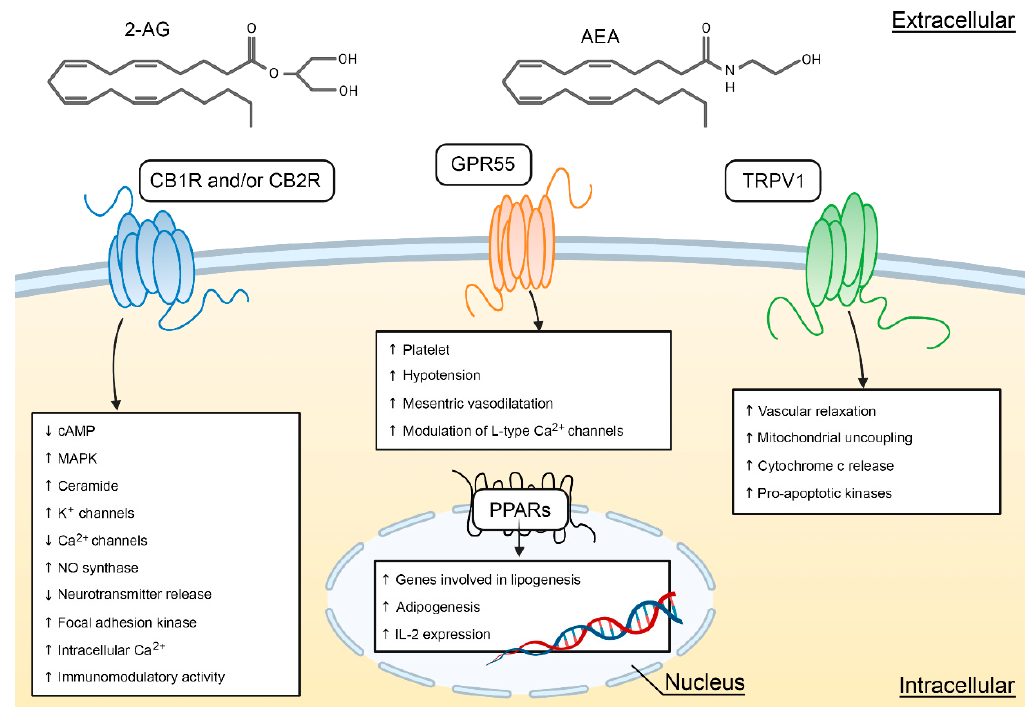
Figure 2. Cellular targets and signaling pathways of AEA and 2-AG. This figure illustrates the main cellular effects for CB1R/CB2R, GPR55, and TRPV1. Redrawn from [19] and created with BioRender.com.